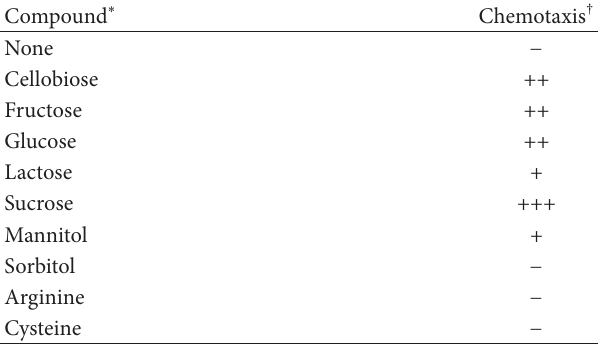
F 1: Phase contrast micrograph showing L. saburreum bound to T. denticola in the presence of P. gingivalis outer membrane vesicles following the piggyback assay. Magni�cation: